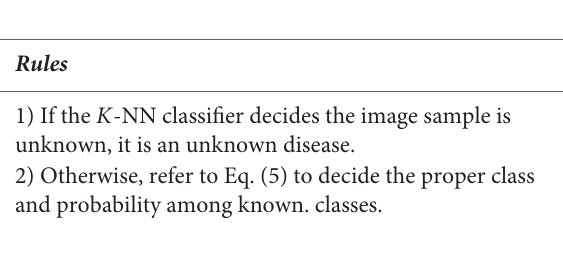
FIGURE 6 | Sample images of normal leaf, fruit, flower, and runner, with